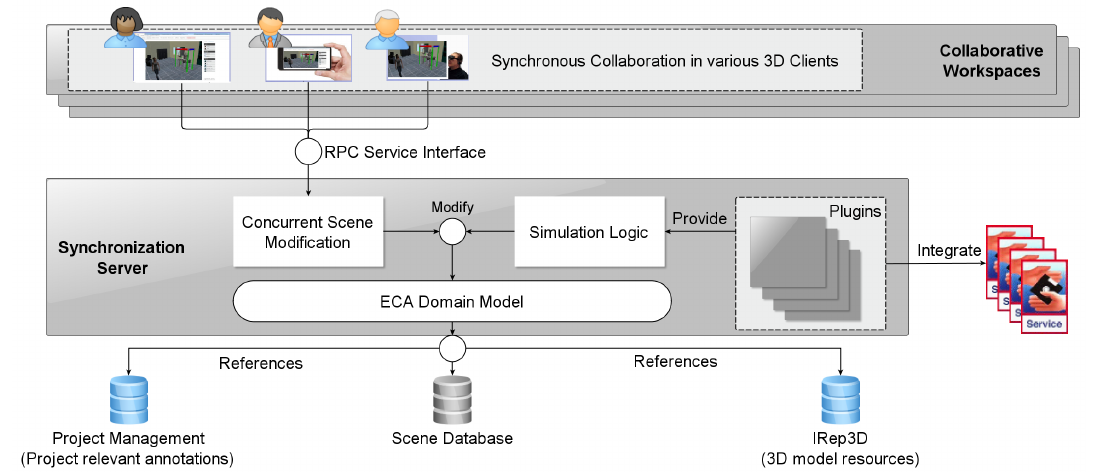
Figure 7. Collaborative Workspace architecture with employed synchronization